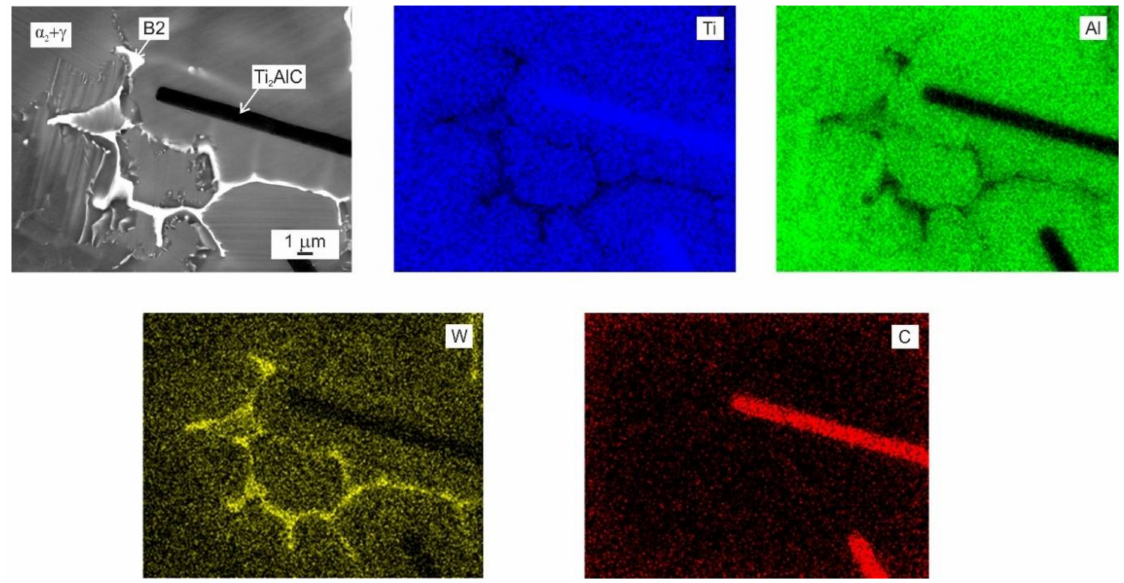
Figure 9. BSE micrograph and corresponding EDS map analysis of the as-cast C20 alloy. The analysed elements such as Ti, Al, W, and C are marked in the EDS map